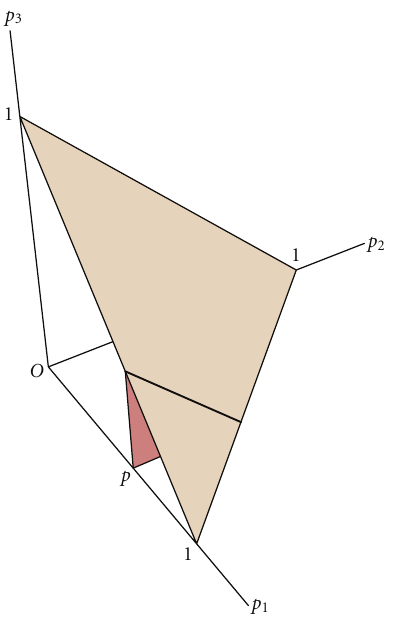
Figure 19: The first quadrant of plane equation (21).